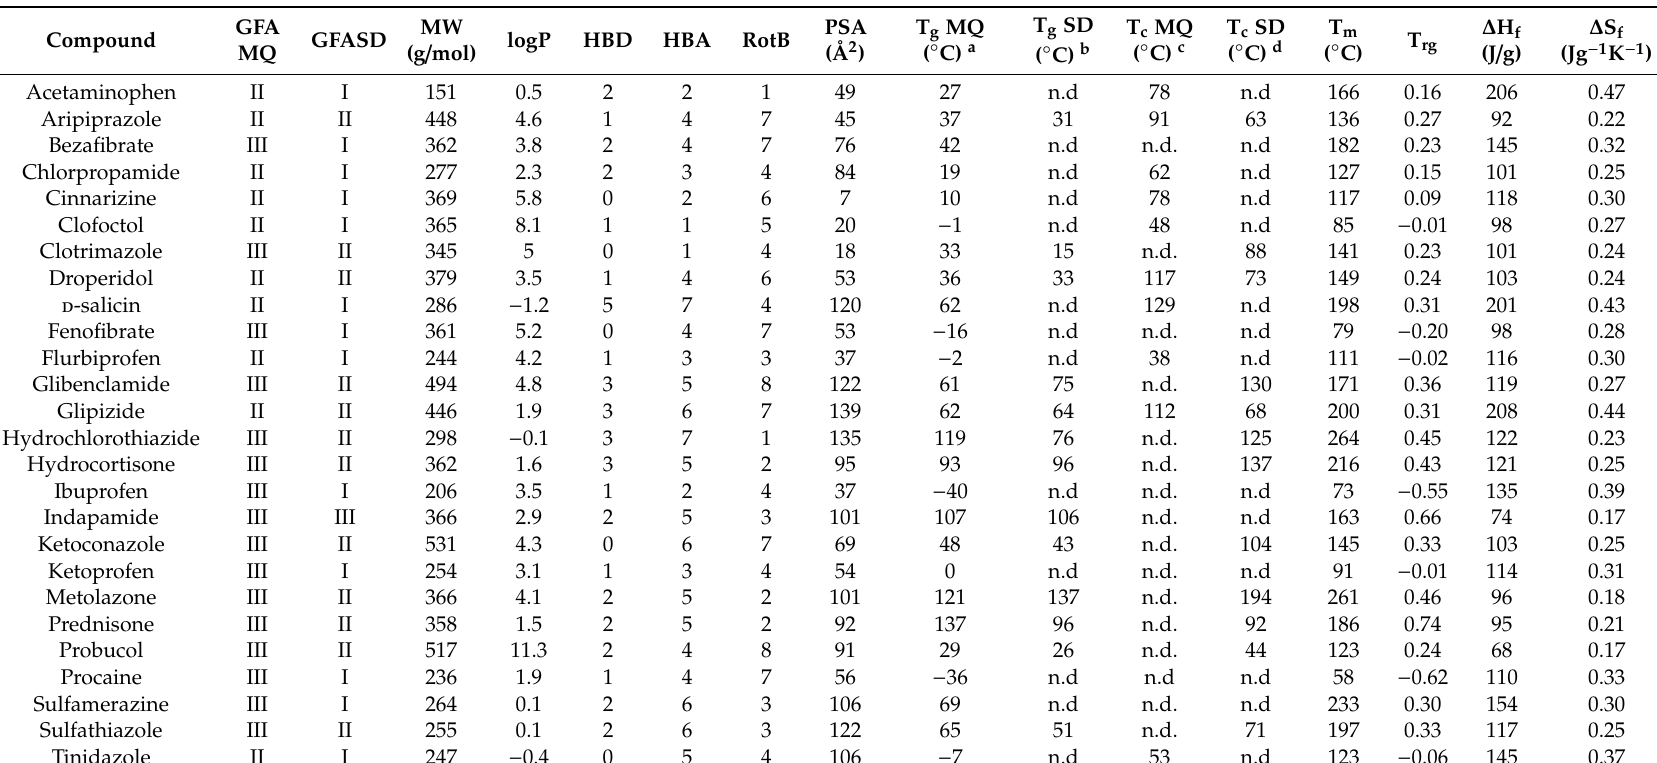
Table 1. Model compounds and their respective physicochemical properties and glass-forming ability classes via melt-quenching and spray-drying method. Compound